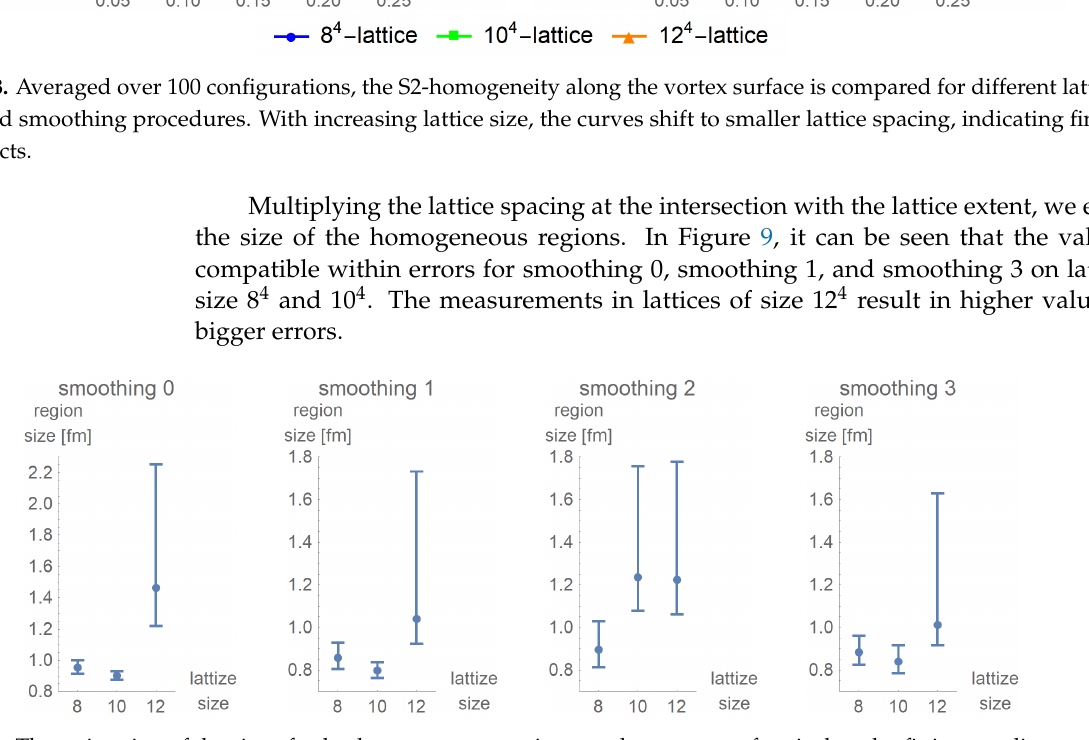
Figure 9. The estimation of the size of color-homogeneous regions on the vortex surface is done by fitting two lines to the data, see Figure 4. The asymmetric errors are calculated via the mean prediction bands of the respective